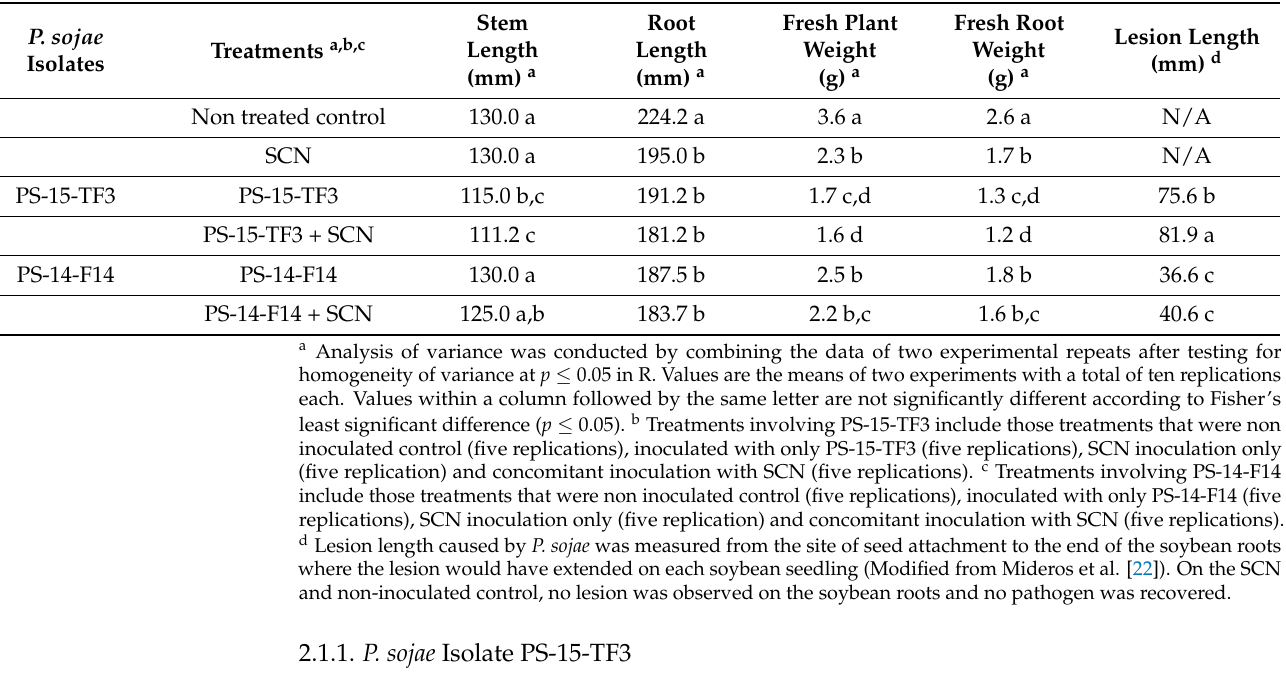
Table 5. Shoot, root length and weight, lesion length measurements observed on the soybean cv. Williams inoculated with SCN or concomitant inoculations of SCN with either of the P. sojae isolates (PS-15-TF3 and